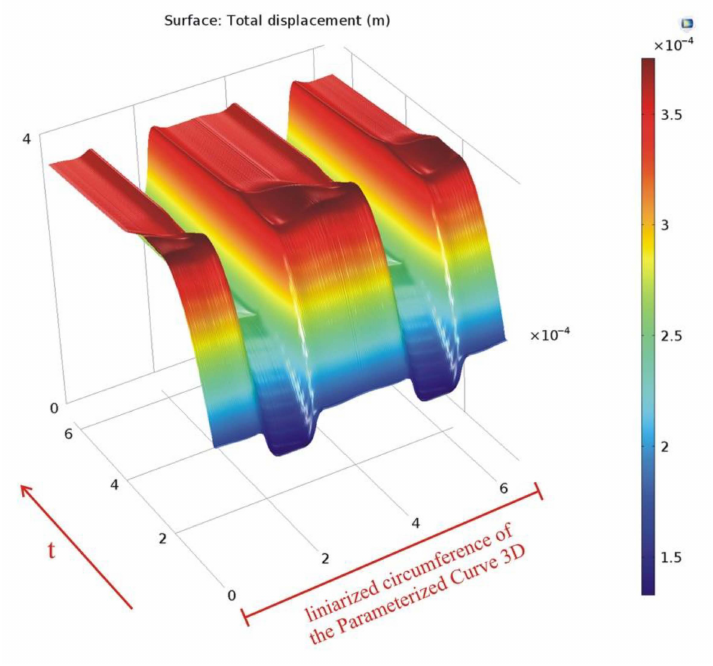
Figure 14. Variation in time of the deformation along the parameterized curve.